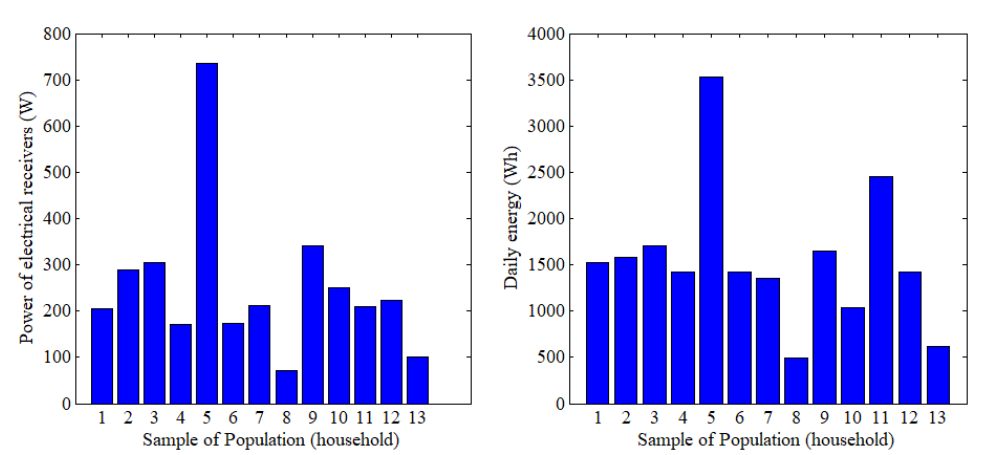
Figure 6. Energy balance by household sample